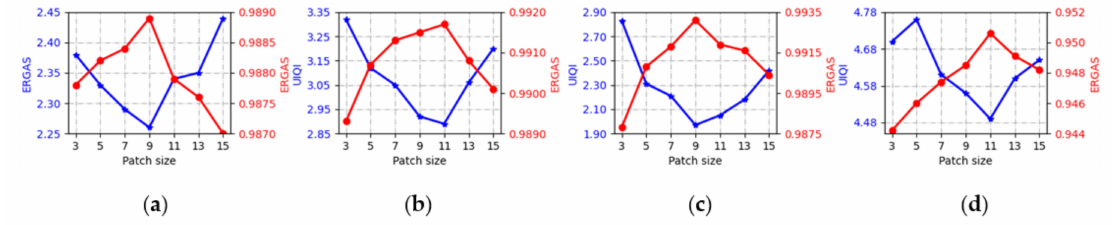
Figure 9. The ERGAS and UIQI values with respect to the patch size of MS image. ( a ) University of Pavia; ( b ) Pavia City center; ( c ) Washington DC Mall; ( d ) San